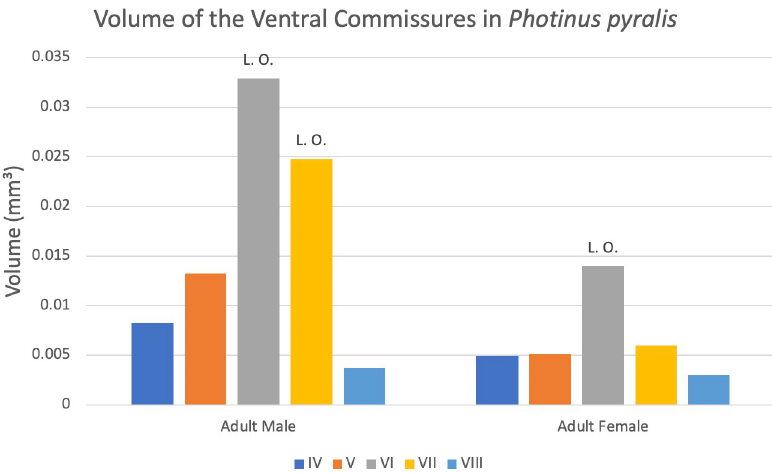
Fig 28. Volume of the ventral commissures in abdominal segments IV–VIII of adult male and female Photinus pyralis . “L. O.” indicates the presence of a light organ on that segment.